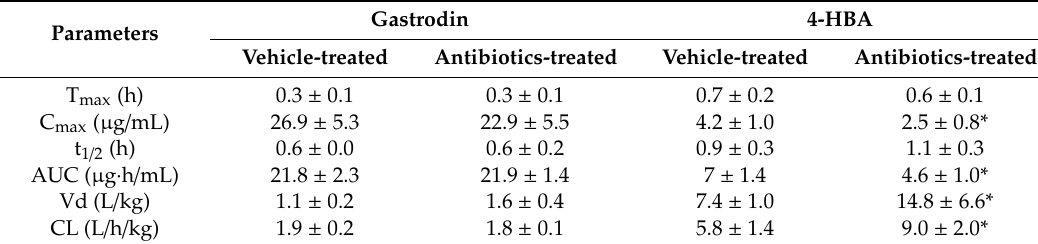
Table 3. Pharmacokinetic parameters of gastrodin and